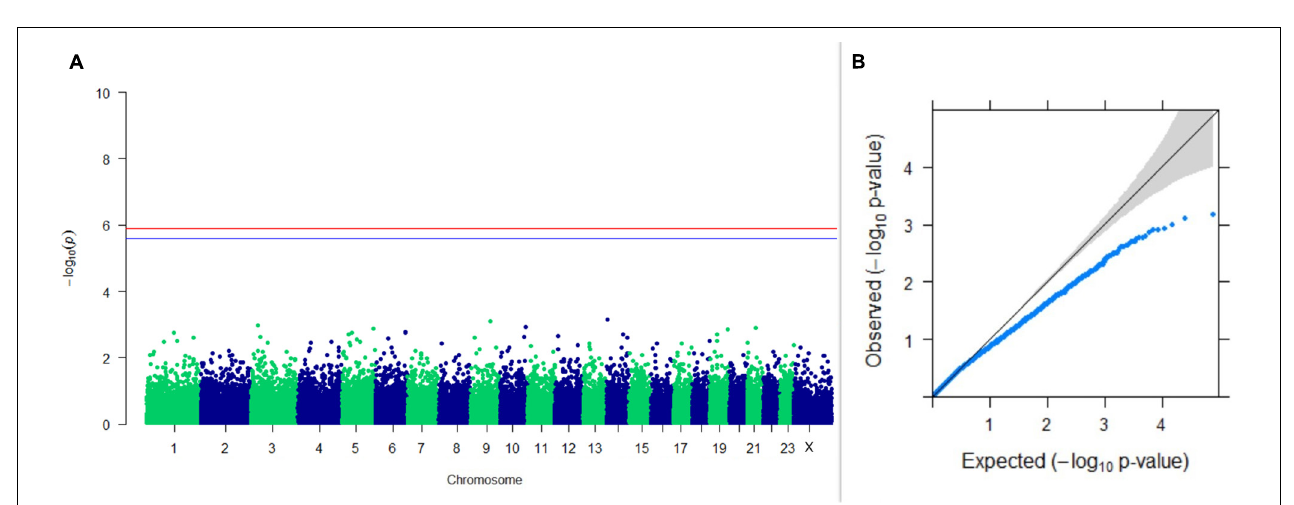
FIGURE 7 | Results of GWAS for 305 days’ milk yield. (A) Manhattan plot of genome-wide SNPs. The red line indicates the p- value threshold (expressed as –log 10 P ) corresponding to FDR-corrected p- values or q = 0.05, above which the SNPs are considered to be significantly associated with the trait, while the blue line indicates the genome-wide suggestive threshold at q = 0.1. The SNPs identified on chromosome no. 24 were screened out from analysis because of stringent quality control; hence, it is not represented in the Manhattan plot. (B) Q-Q plot of the p- values.